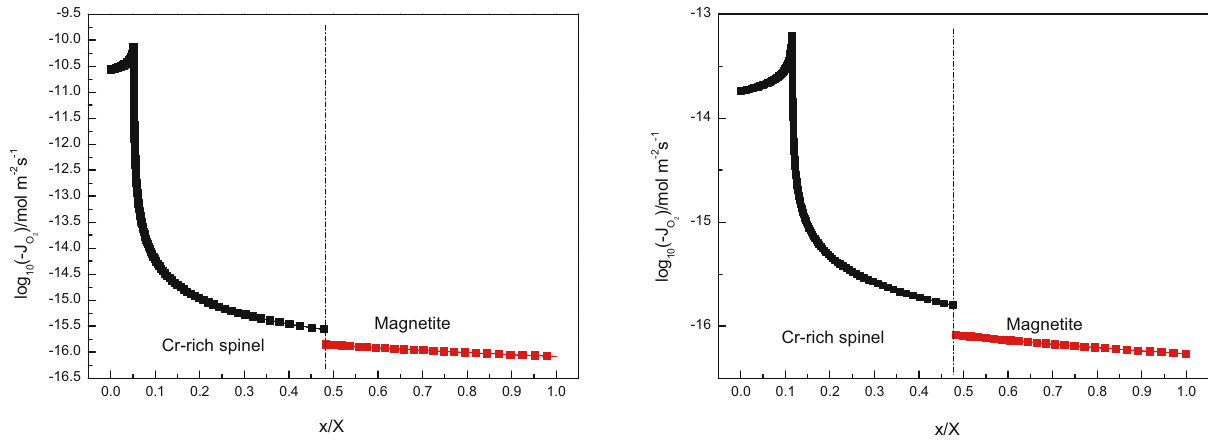
Figure 8: Logarithm of negative of the flux of oxygen ion in oxide scale on HCM12A at 500°C ( left ) and 600°C ( right ) over normalized position.